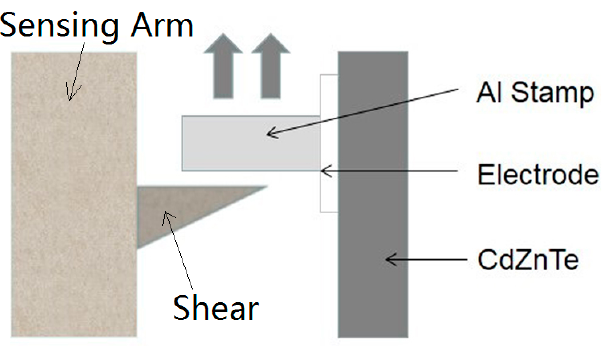
Figure 3. The schematic diagram of the film adhesion test.